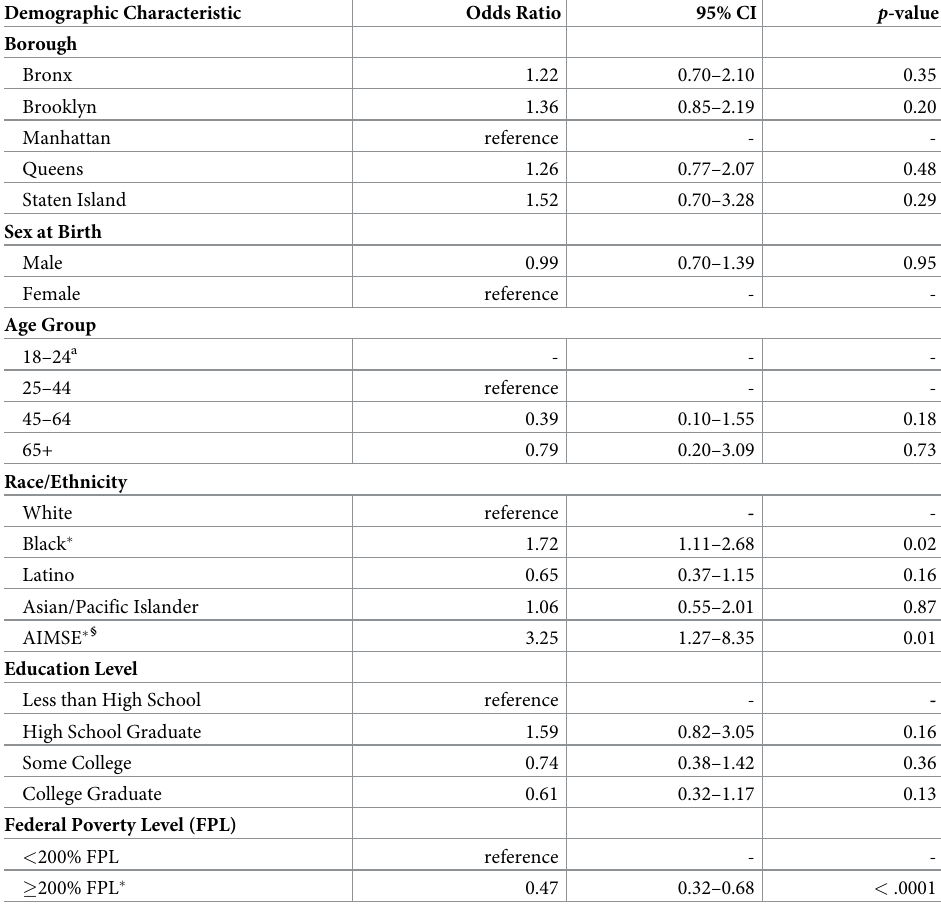
Table 7. Odds of responding to a mail (paper survey) invitation 1 .